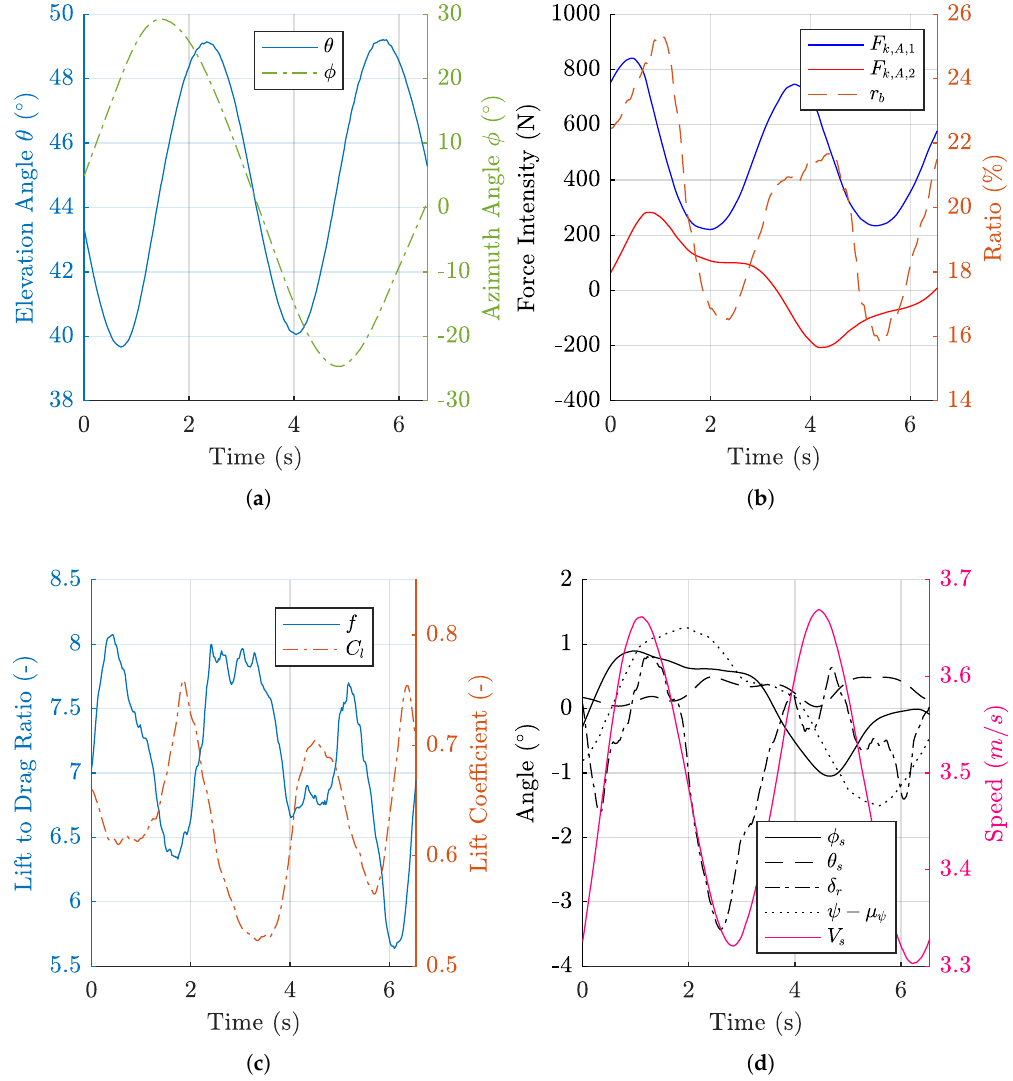
Figure 18. Results of the phase-averaging process applied to a downwind run (case d05f4). ( a ) elevation and azimuth of the kite. ( b ) tension on back tethers and back tether ratio. ( c ) lift coefficient and lift to drag ratio of the kite. ( d ) attitude and speed of the